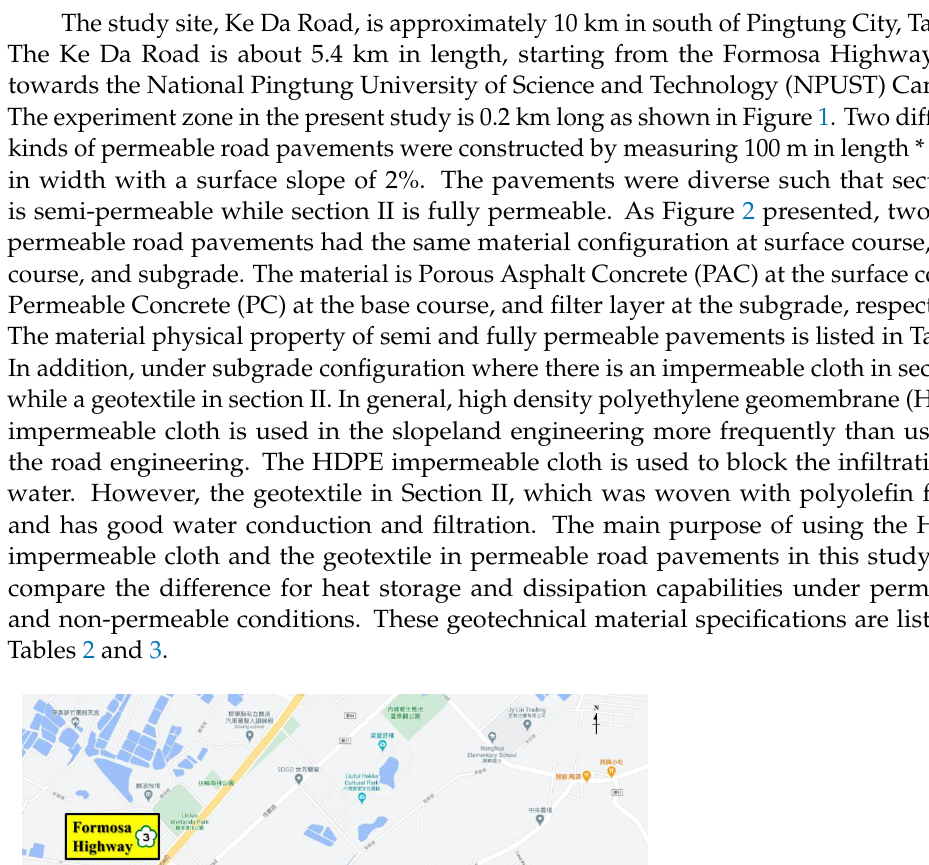
Figure 2. The pavement designs of this study.